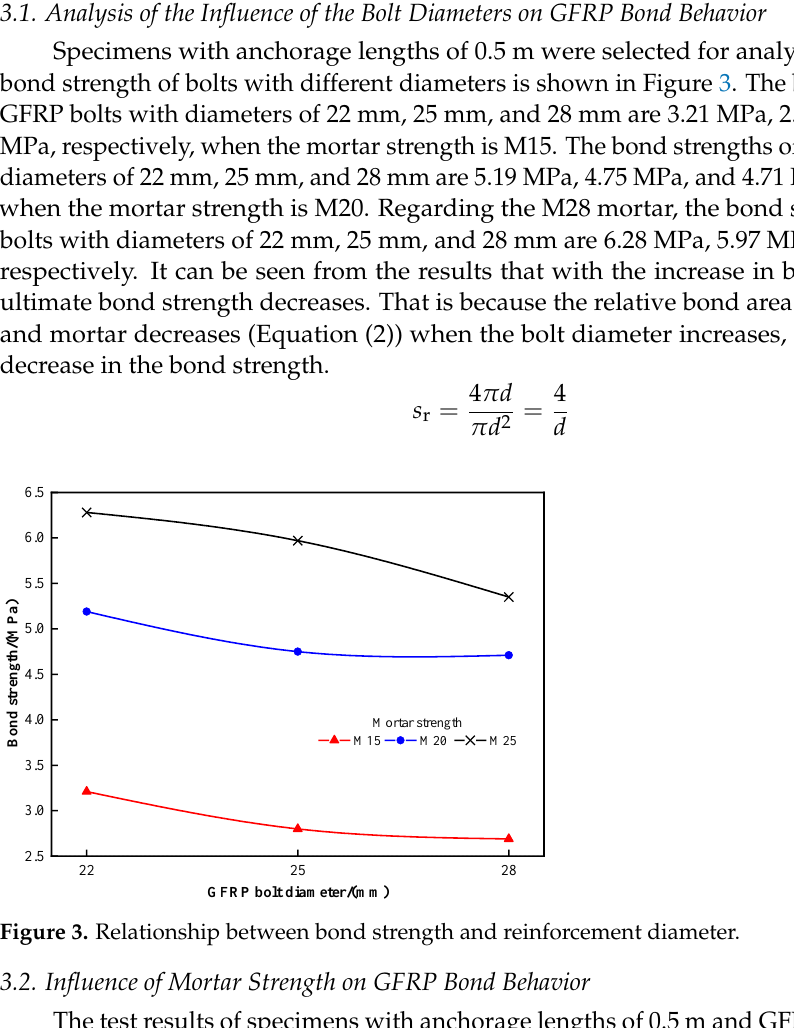
28 mm Figure 5. Relationship between anchorage length and bond strength.